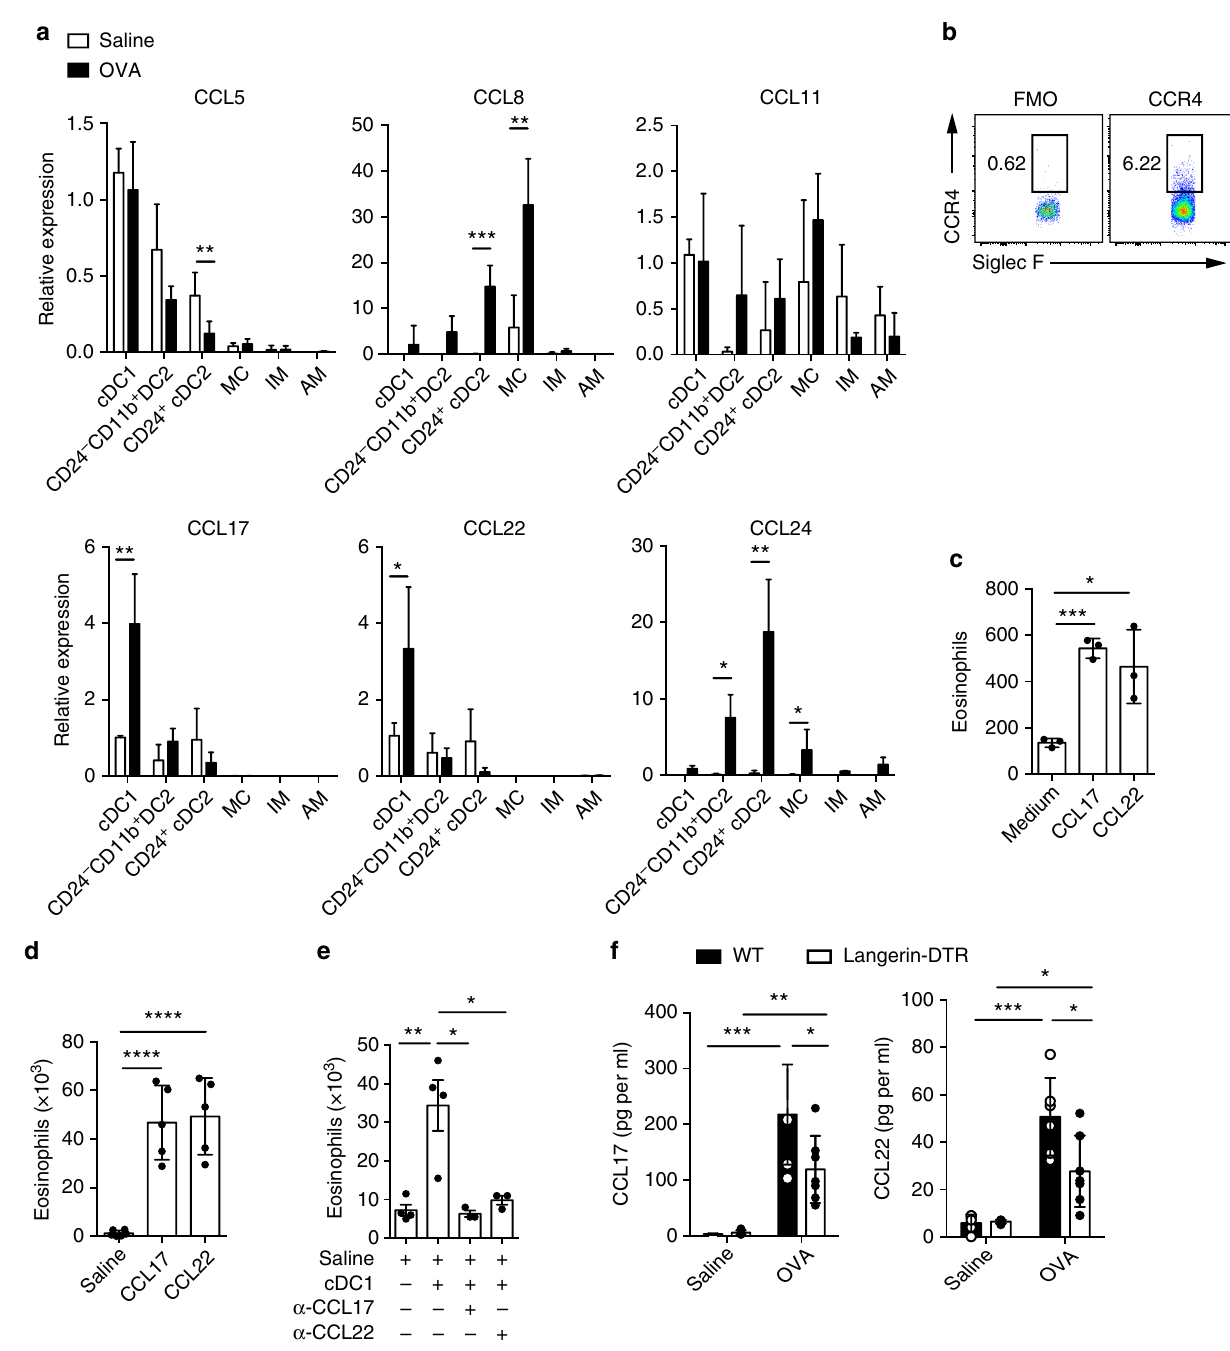
Fig. 3 Lung cDC1s directly recruit eosinophils via CCL17 and CCL22. a mRNA expression of CCL5 , CCL8 , CCL11 , CCl17 , CCL22 , and CCL24 chemokines by lung cDC1s, CD24 + cDC2s, CD24 − CD11b + DC2s, MCs, IMs, and AMs isolated from mice 1.5 days after the fi rst OVA challenge. mRNA expression was fi rst normalized against the housekeeping GAPDH genes and then represented as relative expression compared to the cDC1s from saline-treated mice. n = 3 – 4 mice per group. b FACS analysis of CCR4 expression on lung eosinophils from naive C57Bl/6 mice. c The direct chemotactic effect of CCL17 (100 pg per ml) and CCL22 (100 pg per ml) on eosinophils was evaluated in a transwell culture system. n = 3 per group. d Counts of eosinophils recruited into the air pouches of wild-type mice 5 h after injection of CCL17 (150 pg) or CCL22 (150 pg) with 500 μ l of temperature-sensitive surface gel. n = 5 – 6 mice per group. e Counts of eosinophils recruited into the air pouches of wild-type mice injected with pulmonary cDC1s (SiglecF − CD11c + IA/IE + CD103 + CD11b − ) from OVA-challenged C57Bl/6 mice with CCL17 or CCL22 neutralizing antibody or goat IgG isotype control. n = 3 – 4 mice per group. f ELISA analysis of CCL17 and CCL22 in Balf supernatant from DT-treated langerin-DTR (empty rectangle) or wild-type (solid rectangle) mice 1.5 days after the fi rst OVA challenge. n = 5 – 7 mice per group. * P < 0.05, ** P < 0.01, *** P < 0.001, unpaired Student ’ s t test. Means ± SD are shown. Data represent two ( a , b , d , e , f